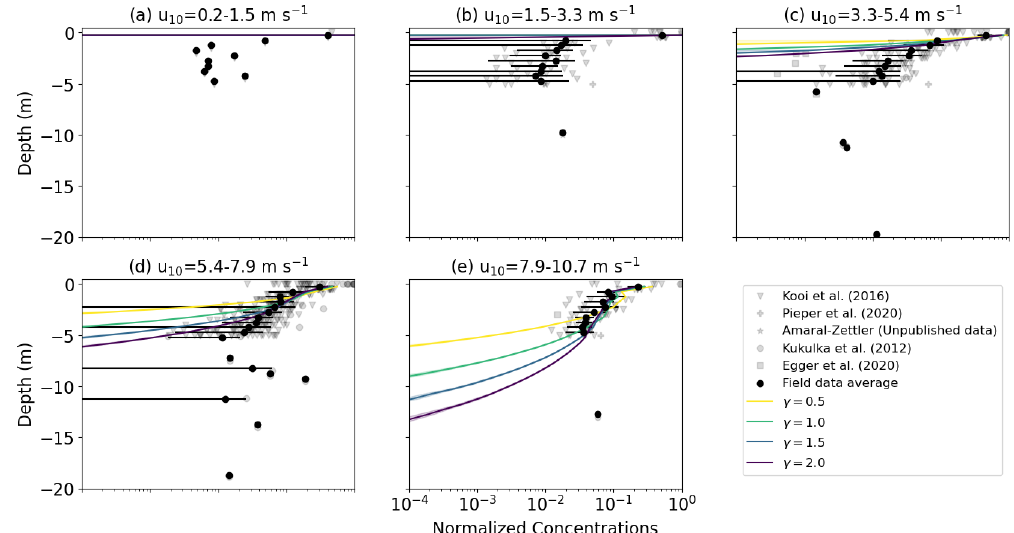
Figure 4. Vertical concentrations of buoyant particles for SWB diffusion under varying wind conditions with w r = 0 . 003ms − 1 . The SWB diffusion profile is calculated with γ ∈ [ 0 . 5 , 1 . 0 , 1 . 5 , 2 . 0 ] . The grey markers indicate field measurements, with darker shades indicating more measurements, while the binned field measurement average and standard deviation are shown by the black markers. Shading around the profiles indicates the profile’s standard deviation at each depth level.